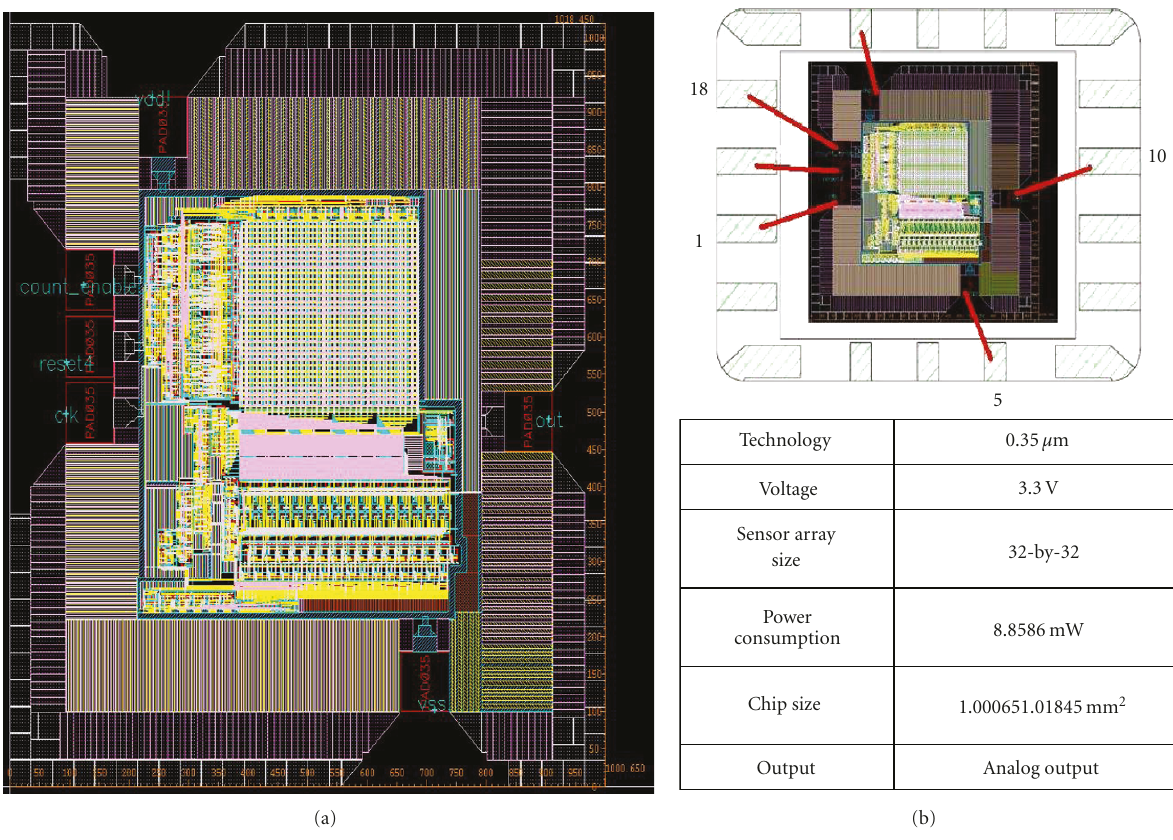
Figure 3: (a) The chip layout of the locally raster-scanning raw image sensor. (b) The package layout and the chip specification of the locally raster-scanning raw image sensor.